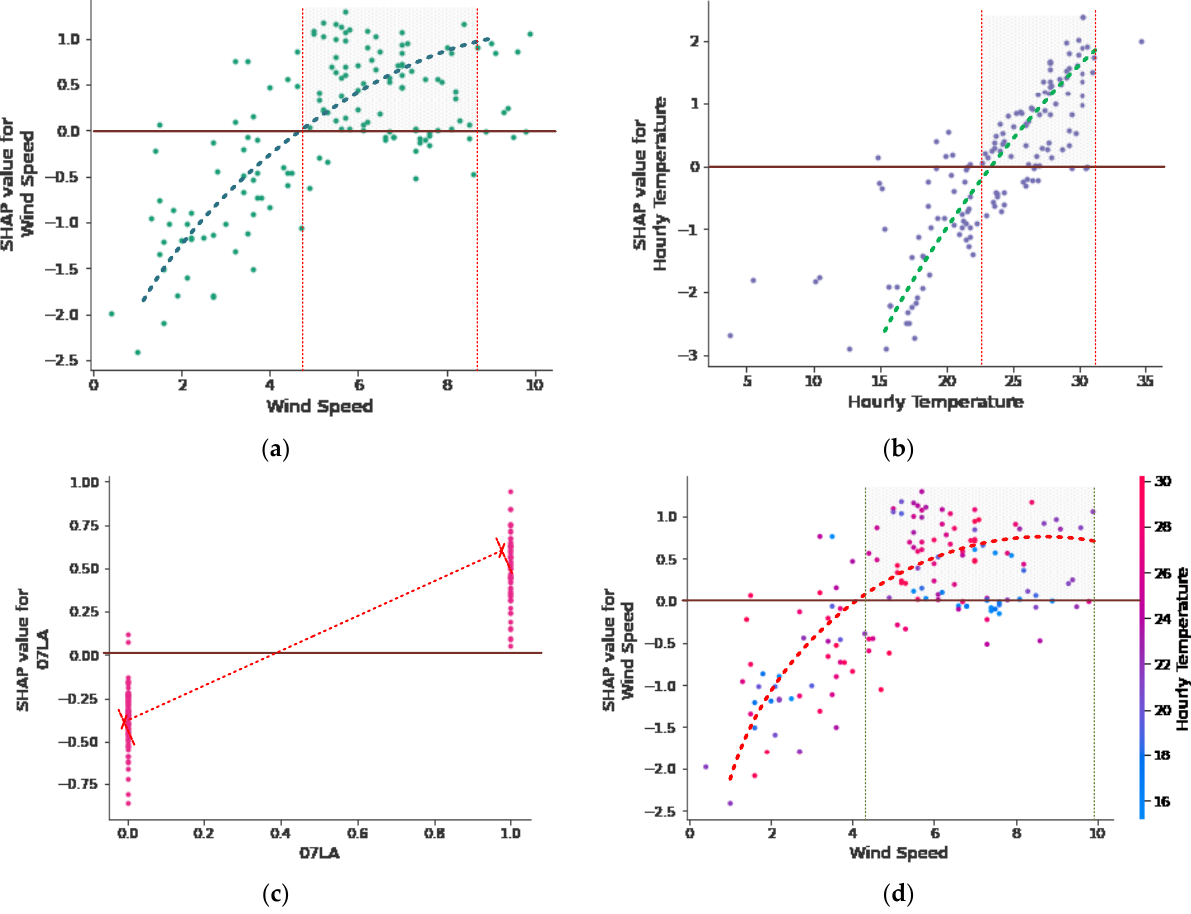
Figure 12. ( a ) SHAP wind speed dependence plot; ( b ) SHAP hourly temperature dependence plot output; ( c ) SHAP Runway 07LA dependence plot; ( d ) SHAP interaction plot of wind speed and hourly temperature.